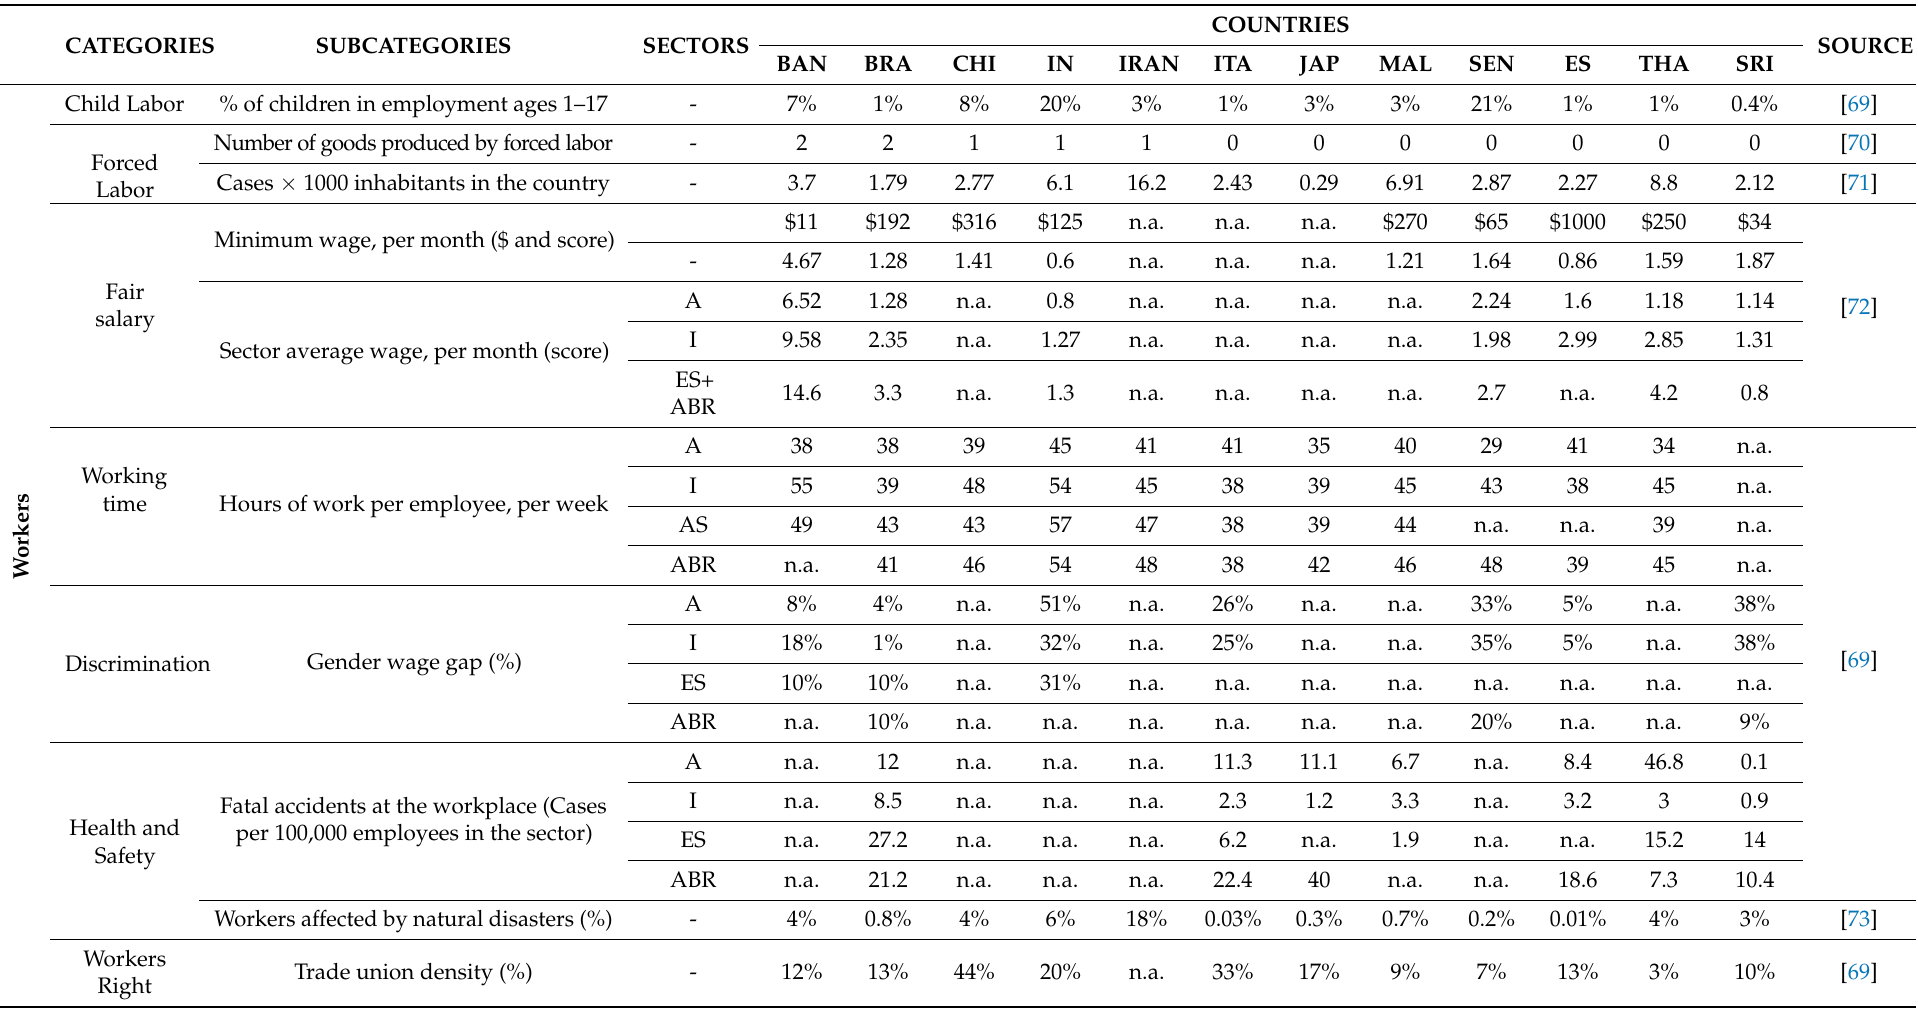
Table 1. S-LCA results for rice production in the countries considered. BAN = Bangladesh; BRA = Brazil; CHI = China; IN = India; IRAN = Iran; ITA = Italy; JAP =